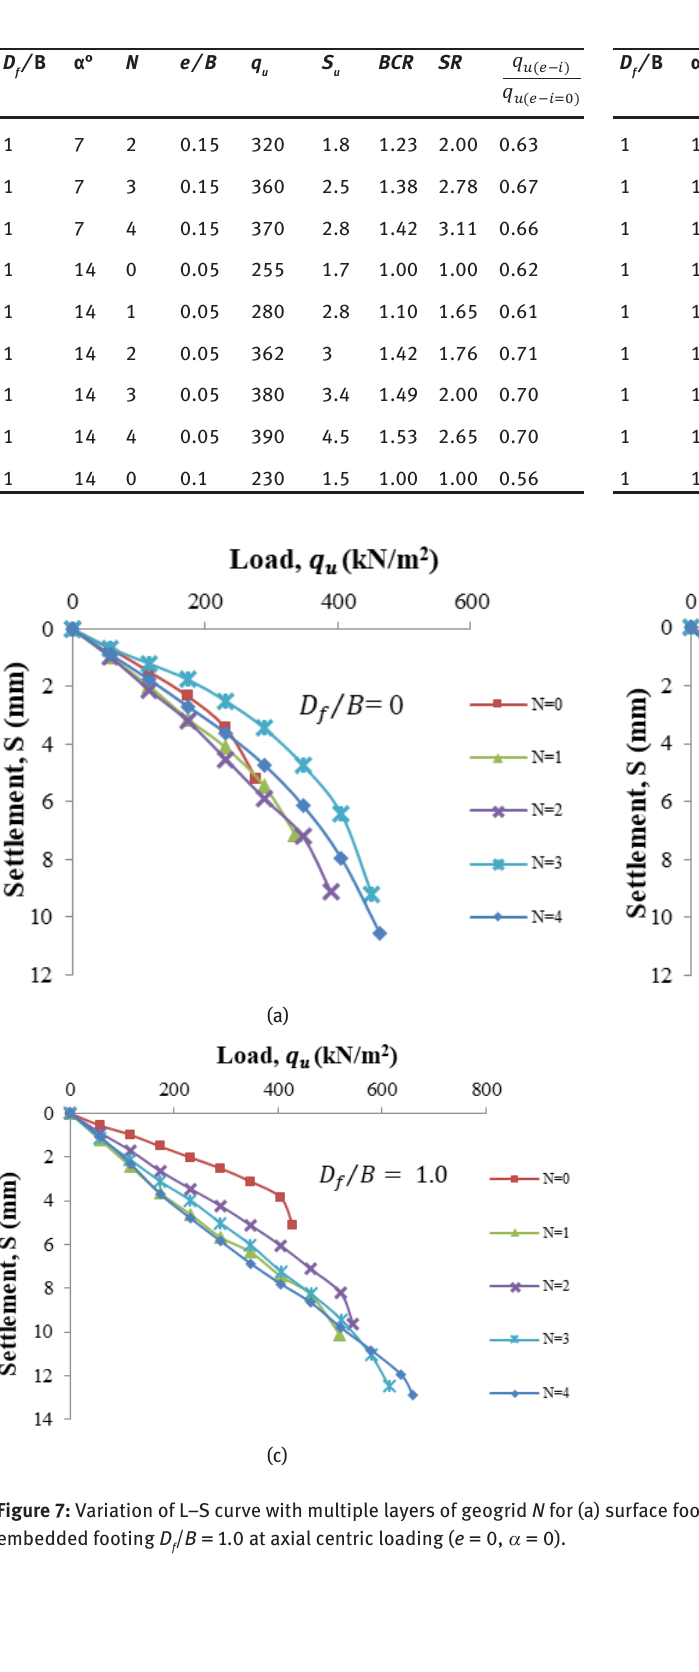
Figure 7: Variation of L–S curve with multiple layers of geogrid N for (a) surface footing D embedded footing D / B = 1.0 at axial centric loading ( e = 0, a = f